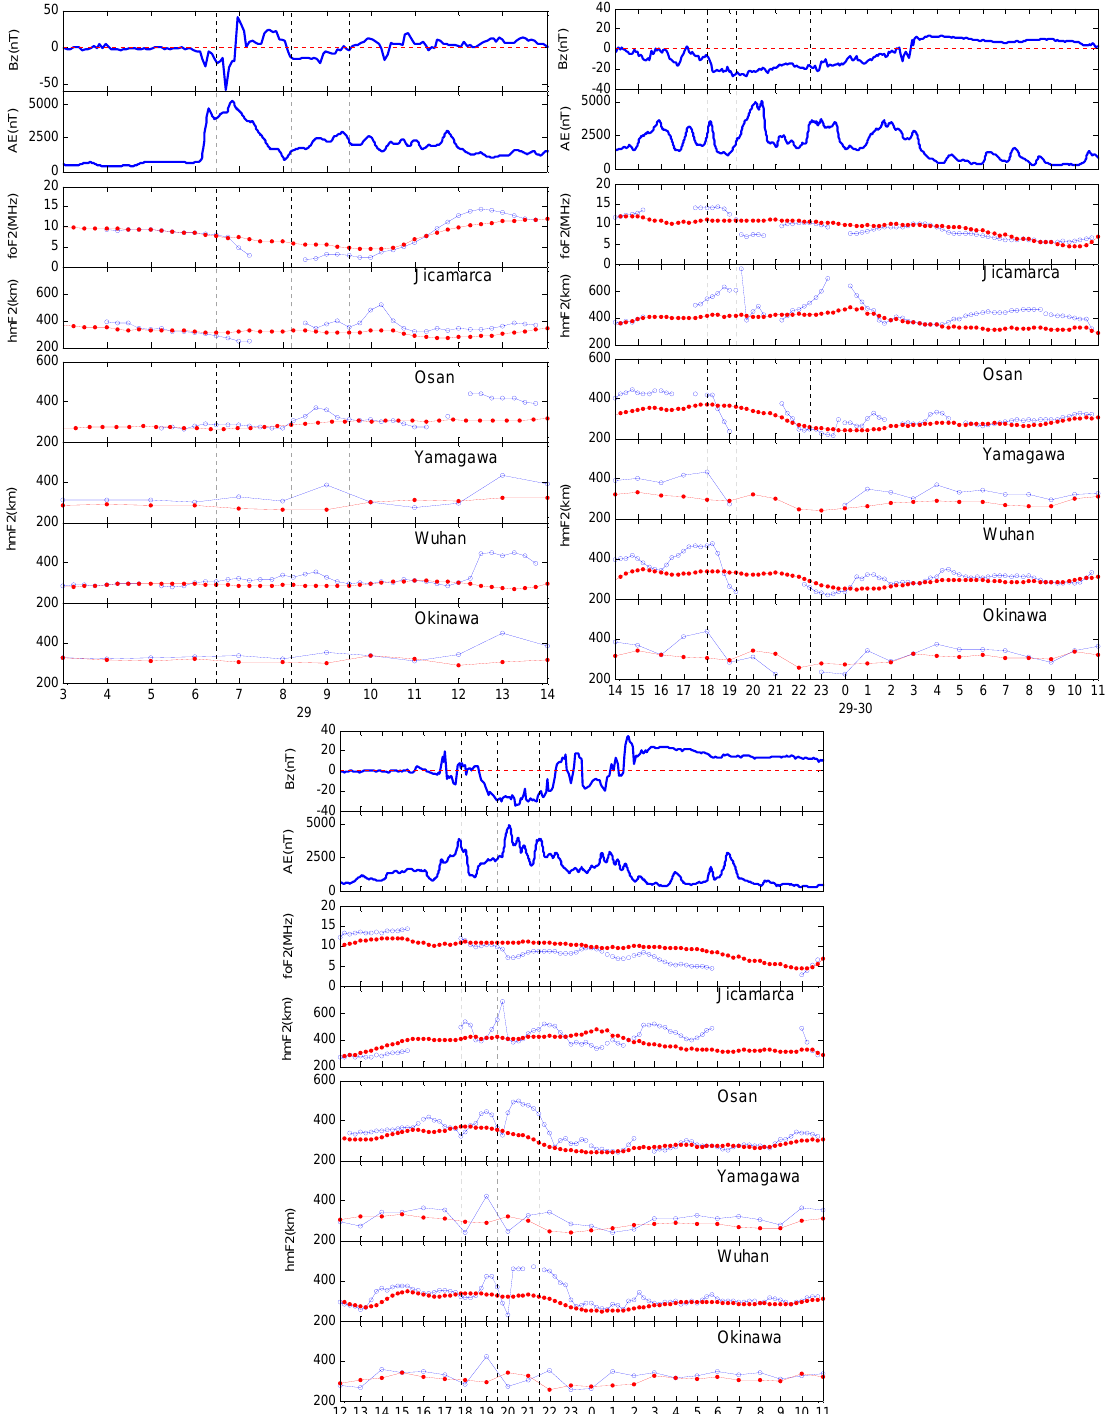
Fig. 6c. Same as Fig. 5a, but for the period 1200 UT on the 30th to 1100 UT on the 31st. The Fig. 6. ( a ) The top panel shows the corresponding AE index and IMF B z during 03:00–14:00 UT, 29 October 2003. The B z has been IMF Bz is shifted to the right by 21 minutes, which is needed for the second shock to travel shifted to the right by 15min, which is needed for the shock to travel from the ACE satellites’s position to the magnetopause. The middle from the ACE satellite’s position to the magnetospause. panel shows the corresponding temporal variations of hmF 2 and f oF 2 at Jicamarca. The bottom panel displays the hmF 2 evolution at the East Asian stations. The red dotted lines denote the monthly average value and the vertical dashed lines mark the distinguished height disturbances. ( b ) Same as Fig. 6a, but for the period 14:00 UT on 29 October to 11:00 UT on 30. ( c ) Same as Fig. 6a, but for the period 12:00 UT on 30 October to 11:00 UT on 31. The IMF B z is shifted to the right by 21min, which is the time needed for the second shock to travel from the ACE satellite’s position to the